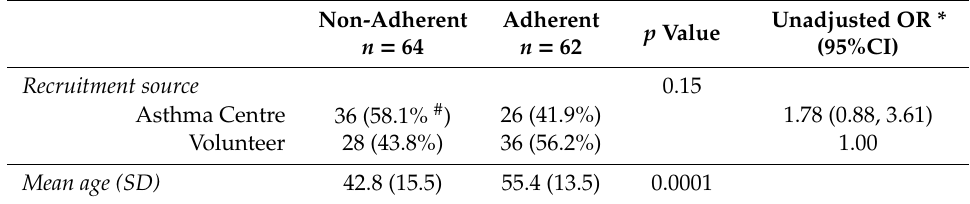
Table 2. Percentage of group non-adherent and adherent and risk of demographic